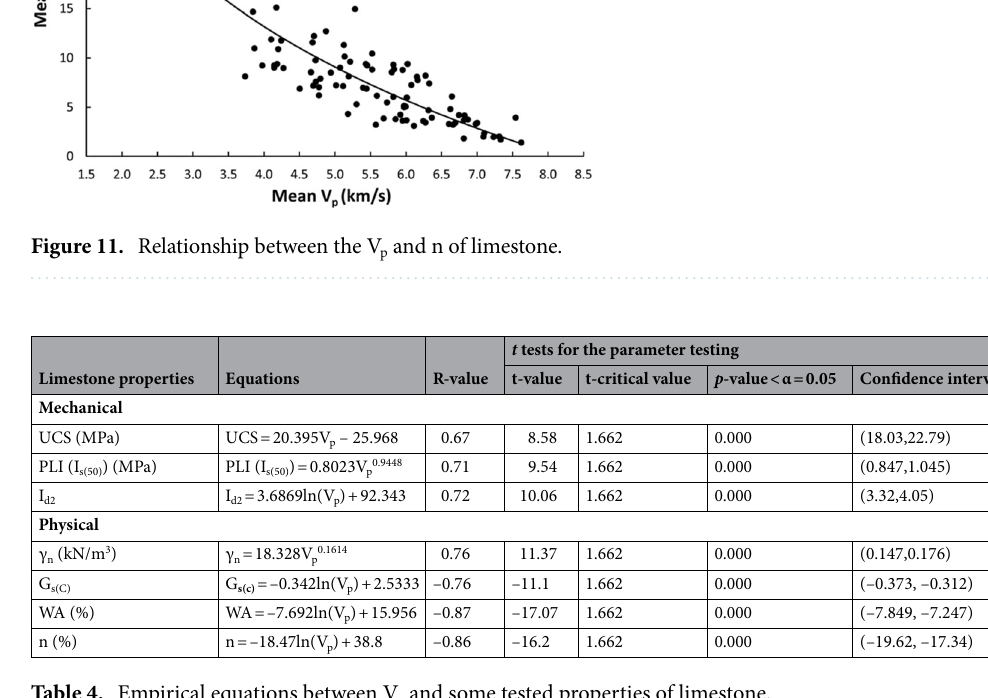
Table 4. Empirical equations between V p and some tested properties of